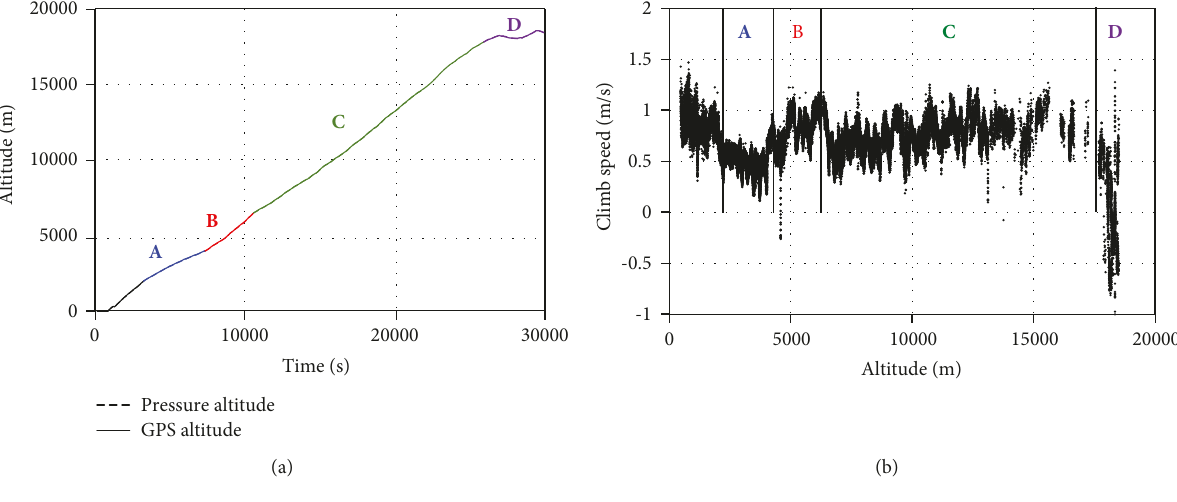
Figure 26: (a) Time history of altitude and (b) climb